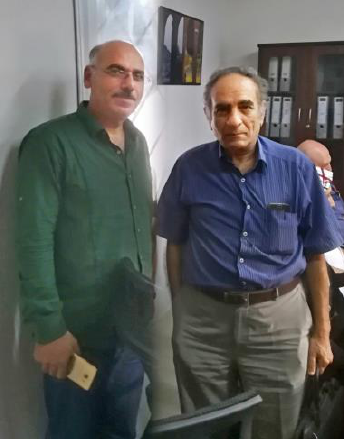
Figure 17. The A. with prof. Hassan Jabreeni, photogrammetrist (left) and prof. Ammar Kaadan, structural Eng. (right).